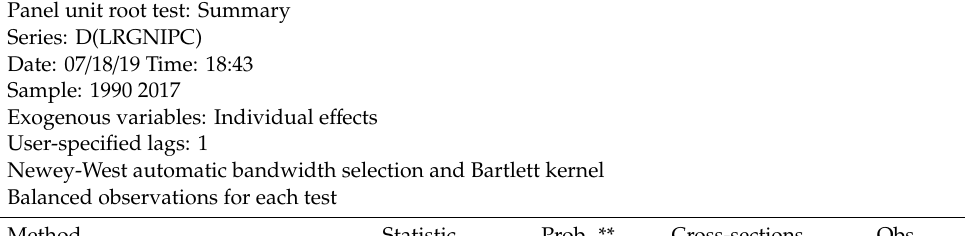
Table A4. Panel Unit Root Test for DLRGNIPC